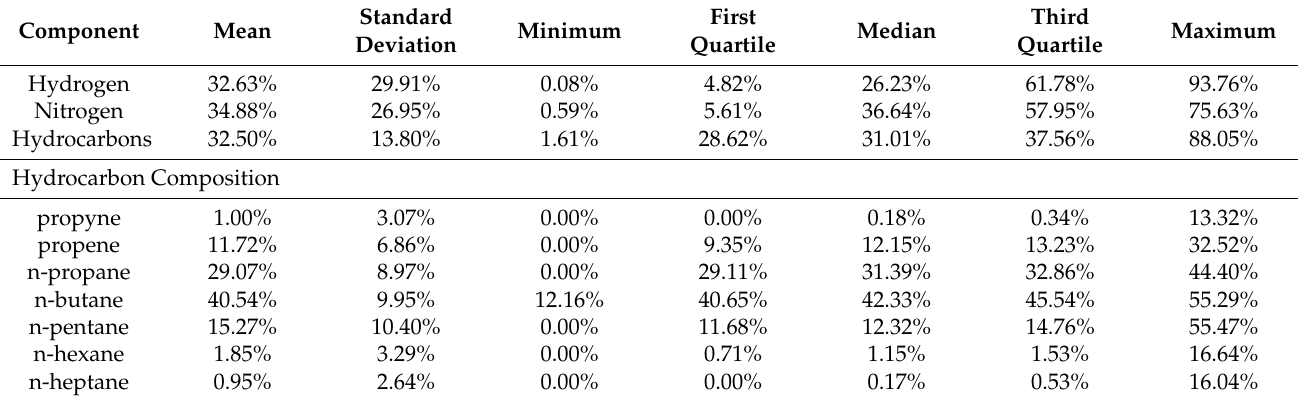
Table 5. Composition of the gaseous products, where T = 273–298 K. n =